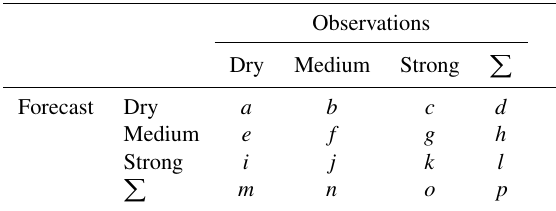
Table A1. General form of a multicategory (3 × 3) contingency ta- ble with a marginal